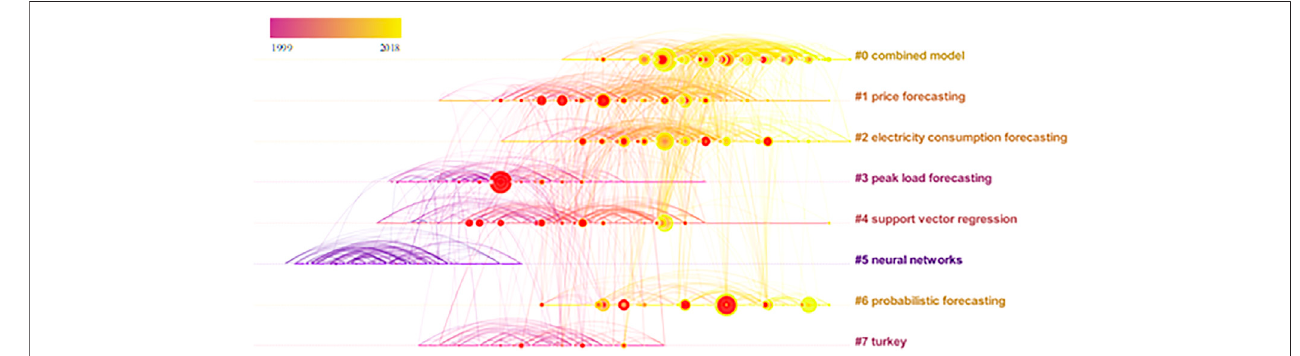
FIGURE 12 | A timeline visualization for the main references cluster.